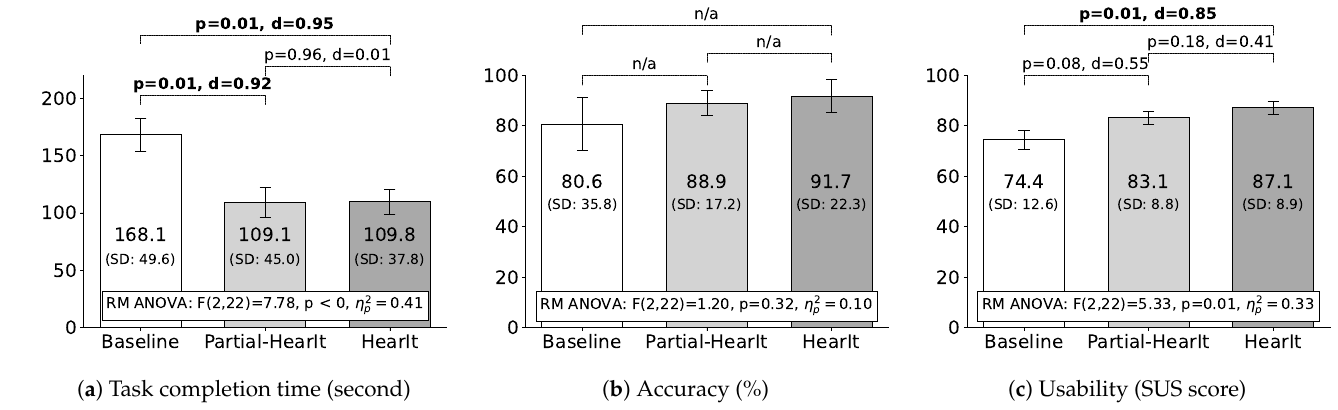
Figure 4. One-way repeated measures ANOVA and posthoc test results.